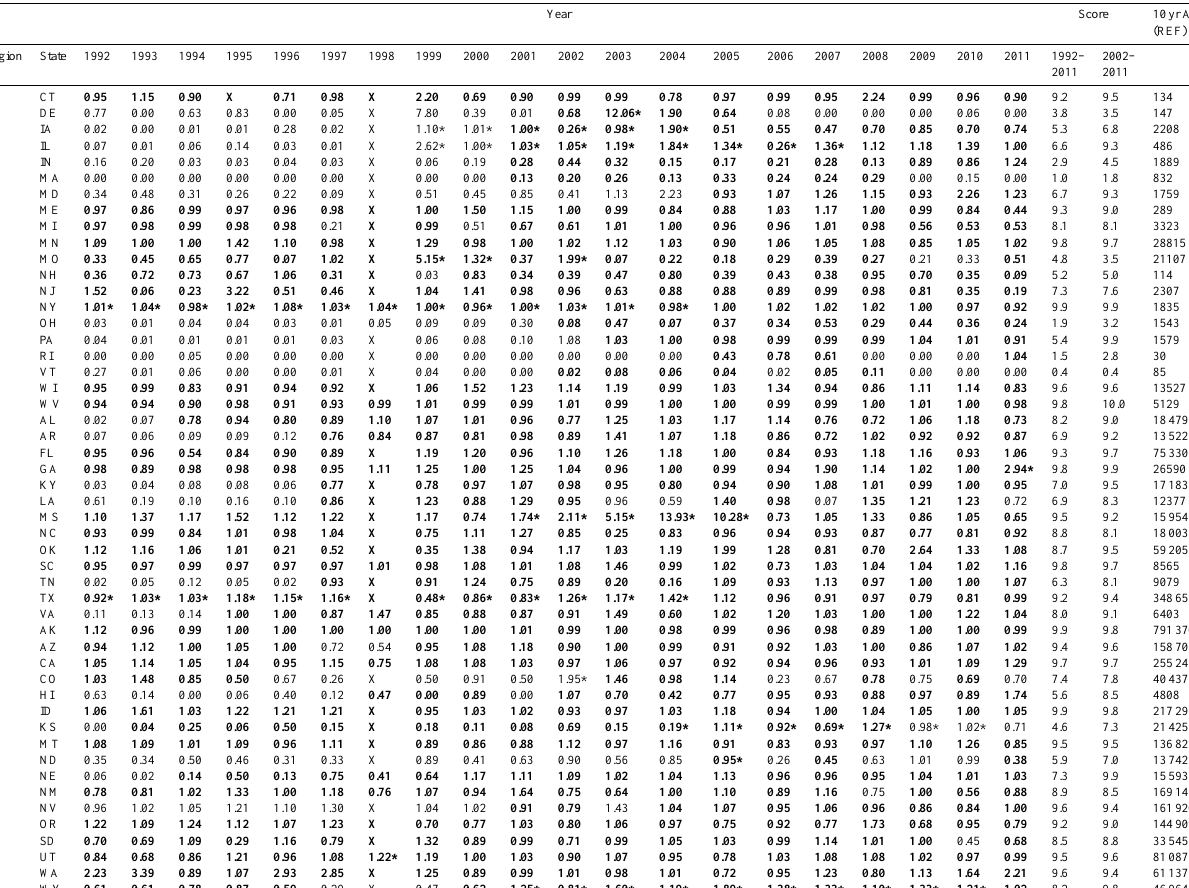
Table 10. Ratio of the wildfire area burned estimated, by US state and year, from the FPA FOD to that from the USFS / NICC reference source. Boldface indicates cases in which at least some viable and non-redundant data were available from the non-federal systems of record and were included in the final FOD. Entries of “X” indicate years and states for which no reference estimate was available. Asterisks (*) indicate cases in which the reference estimate is evidently based on incomplete reporting and therefore biased low. Scores for the full 20yr period and the 10yr span, 2002–2011, and the 10yr average annual wildfire area burned (hectares) calculated from the reference source (REF) are also presented. States are grouped into the following regions, per the National Cohesive Wildland Fire Management Strategy: Northeast (NE), Southeast (SE), and West (W) (see USDI and USDA, 2012). Federal Information Processing Standards (FIPS) codes are used to identify states (NIST,